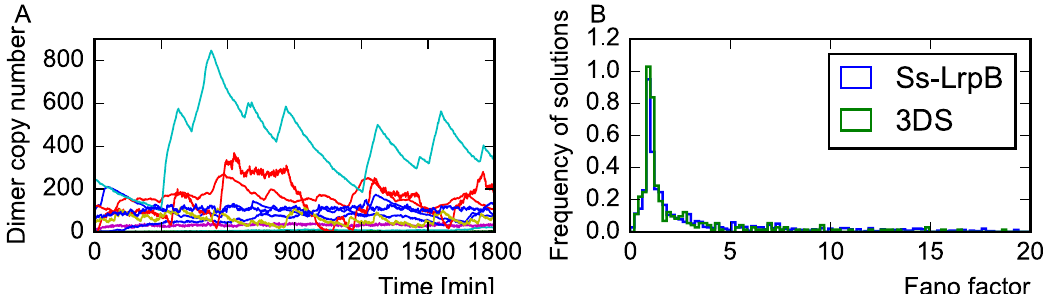
Fig 10. Bursting behavior of the 3DS systems. (A) 15 time traces compatible with the Ss-LrpB system (B) Histogram of Fano factors distributions for 3DS and 3DS systems compatible with Ss-LrpB